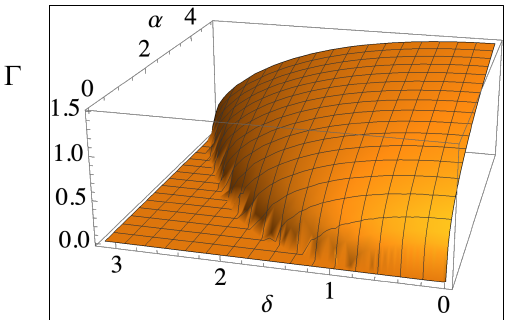
Figure 1. Unstable region: Instability growth rate Γ in the parameter space ( δ , α ) . It represents the growth rate dependence on the detuning parameter δ , and on the collective coupling parameter α . For zero detuning, δ → 0, there is no